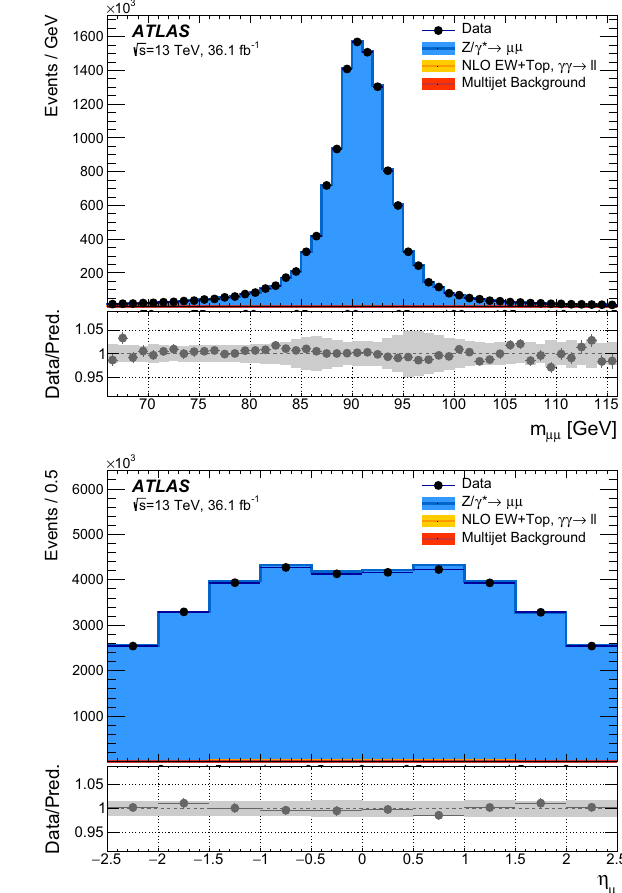
Fig. 1 The distribution of events passing the selection requirements in the electron channel (left) and muon channel (right) as a function of dilepton invariant mass m (cid:3)(cid:3) (upper row) and lepton pseudorapidity η (lower row), the latter with one entry for each lepton per event. The MCsignalsampleissimulatedusing Powheg + Pythia 8.Thestatistical